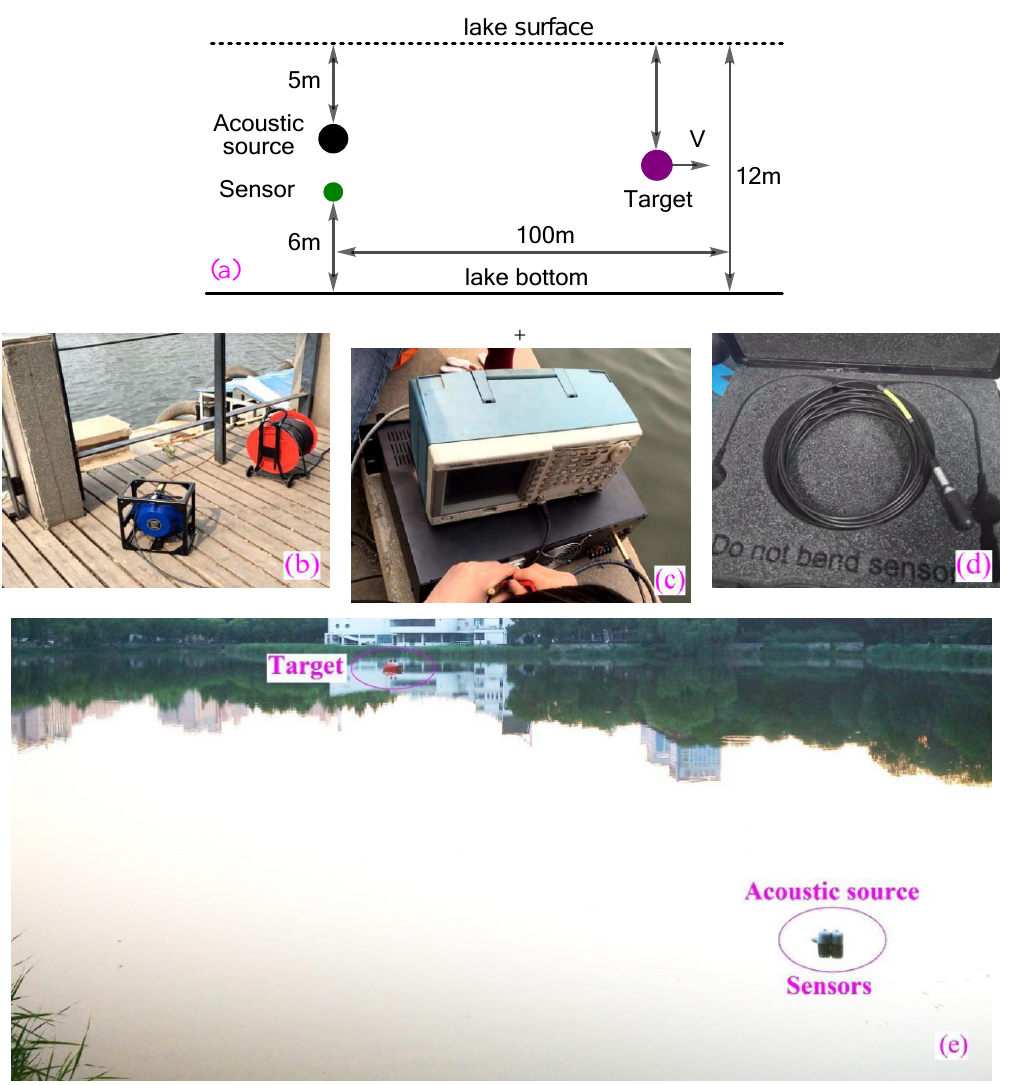
Figure 11. The experimental scenario and relevant parameters. ( a ) The experimental model; ( b ) the broadband acoustic source; ( c ) the corresponding power amplifier; ( d ) the broadband hydrophone; ( e ) the experiment field.